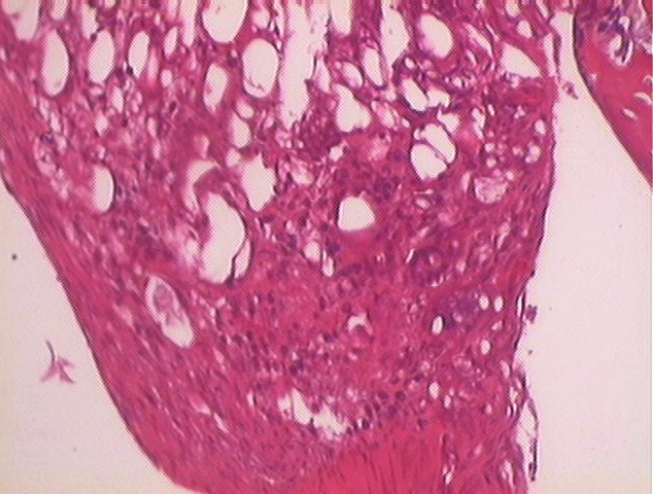
FIGURE 3 - Photomicrography showing inflammatory cell migration to the screw site.